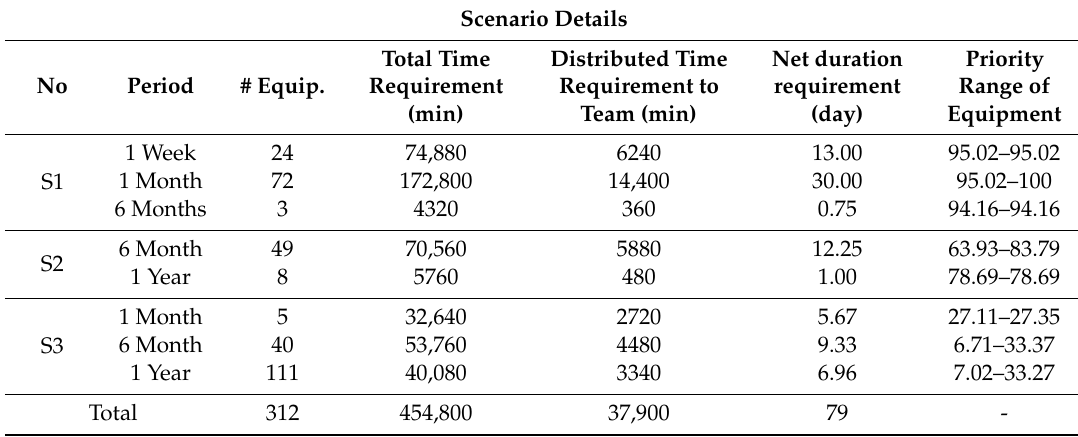
Table 10. Periodic maintenance planning scenario details of electrical equipment.